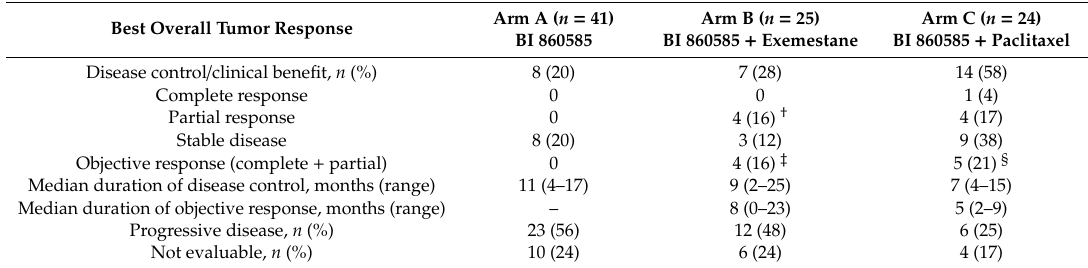
Table 4. Best overall tumor response during